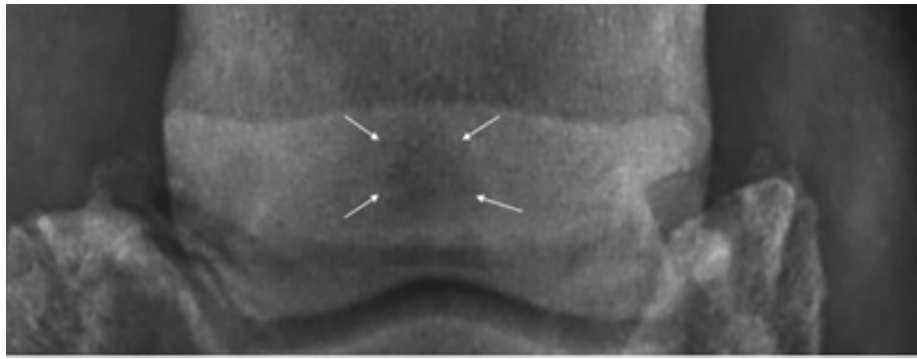
Figure 2. Horses with palmar foot pain: DPr ‐ PaDiO radiolucent area (sclerosis of the medullary cavity) in the navicular bone (white arrows).